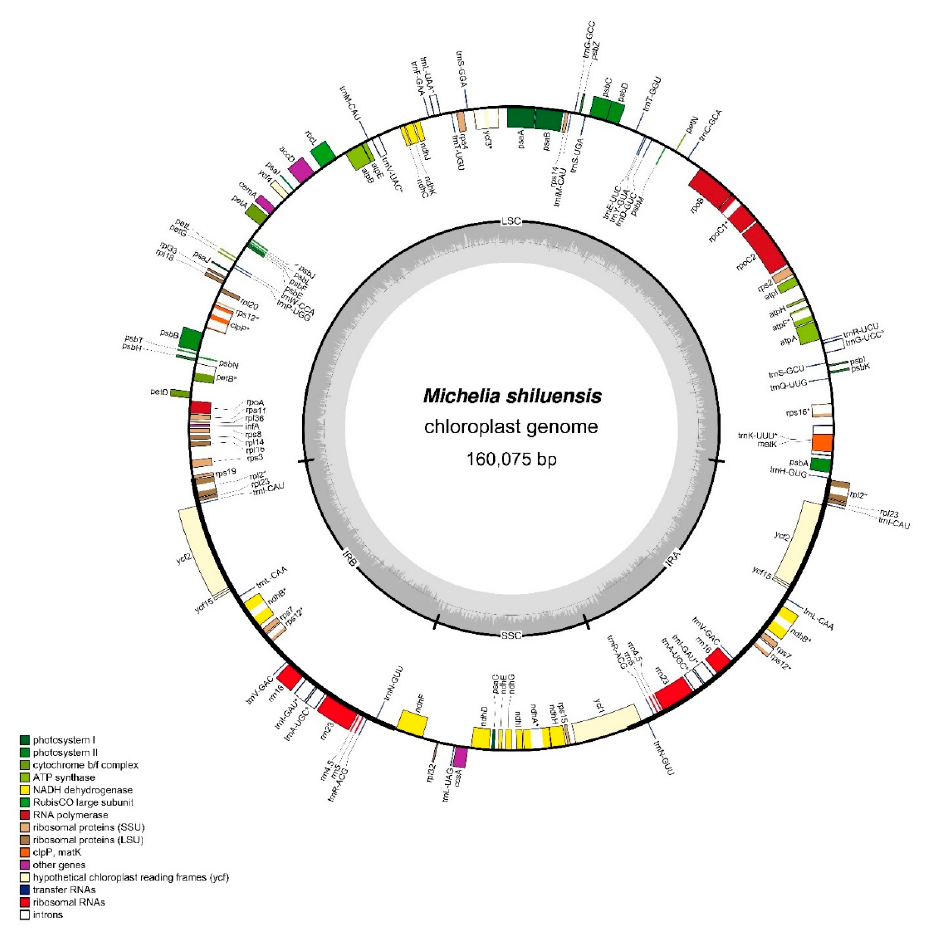
Figure 1. Gene map of the Michelia shiluensis chloroplast genome. Genes on the outside of the circle are transcribed counter-clockwise, while genes on the inside are transcribed clockwise. Di ff erent colors represent di ff erent kinds of functional genes. The guanine-cytosine content is indicated by darker gray and the adenine-thymine content is indicated by light gray. A total of 16 genes were found to have introns, including 10 PCGs and six tRNA genes. Of these genes, clpP , trnA-UGC , trnI-GAU , and ycf3 had two introns, whereas atpF , ndhA , ndhB , petB , rpl2 , rpoC1 , rps12 , rps16 , trnG-UCC , trnK-UUU , trnL-UAA , and trnV-UAC had one intron. The rps12 gene which encodes the 40S ribosomal protein S12, was trans-spliced, with one exon located in the LSC region, and the other two exons located in the IR region. The largest intron was located in the trnK gene (2490 bp) with the matK gene inside; trnL-UAA had the smallest intron (491 bp) (Table 3).